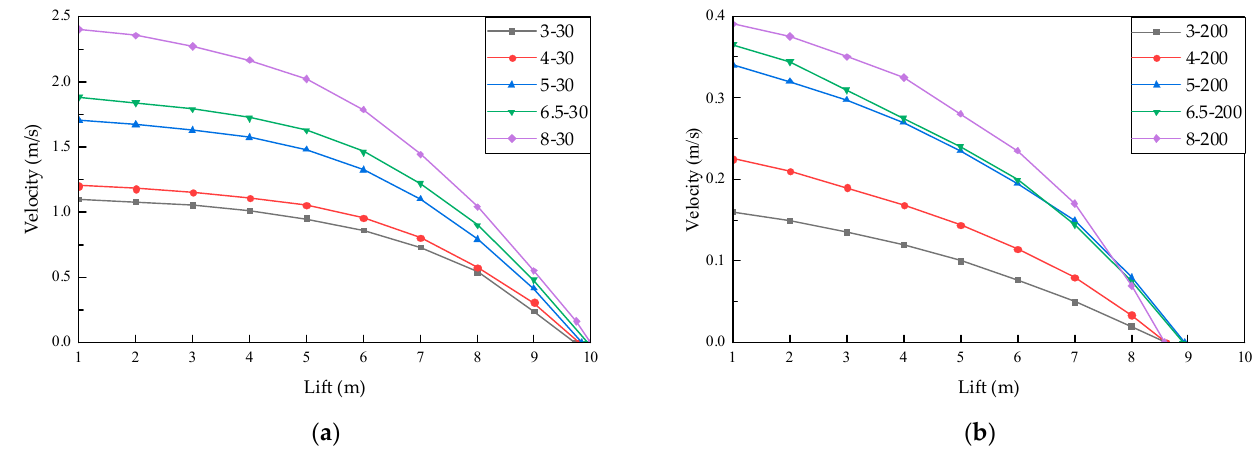
Figure 8. Siphon lift—flow velocity curve: ( a ) Total length of 30m; ( b ) Total length of 200m.